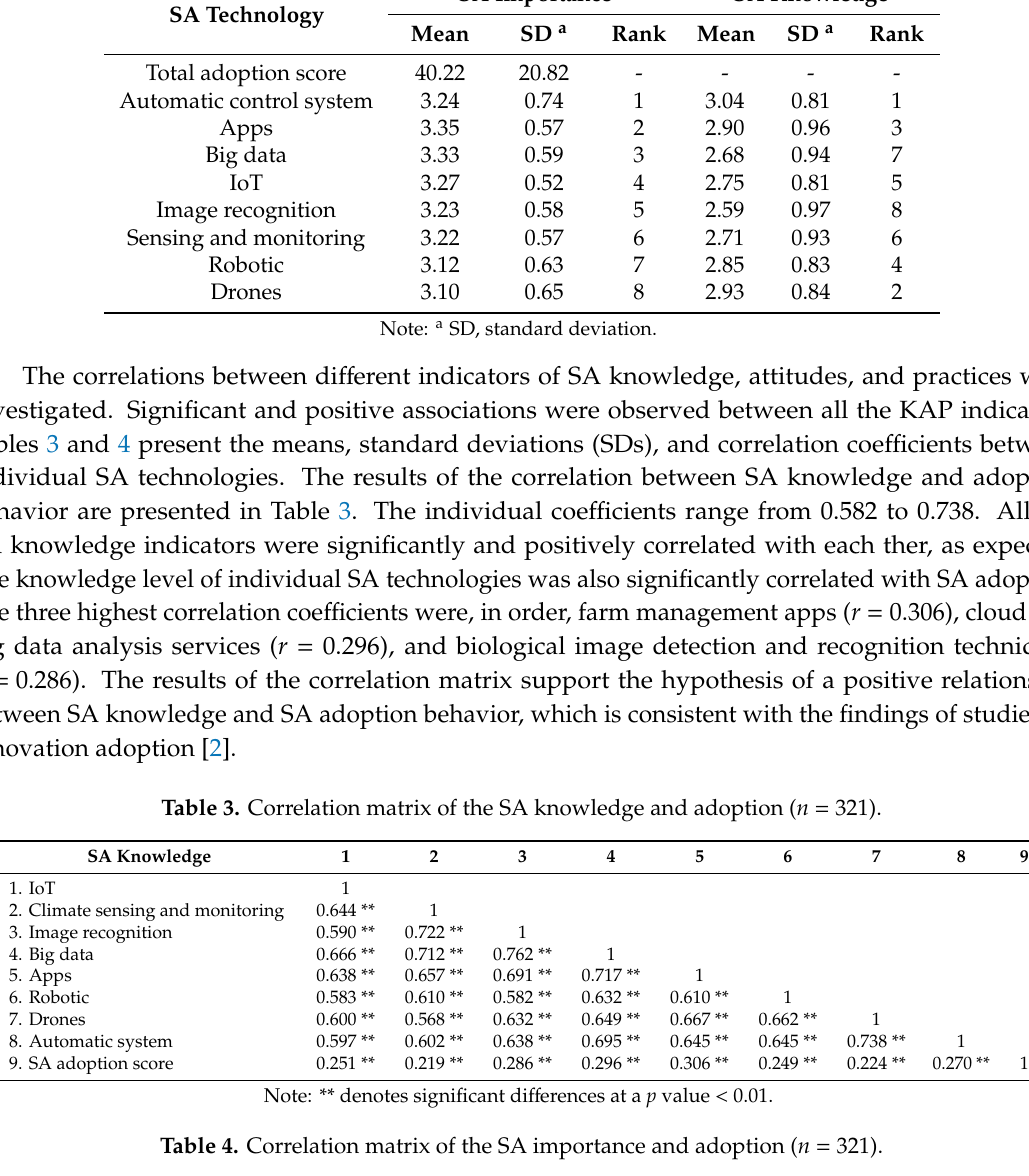
Table 2. Descriptive statistics of smart agriculture (SA) knowledge, importance and adoption ( n = 321). SA Technology